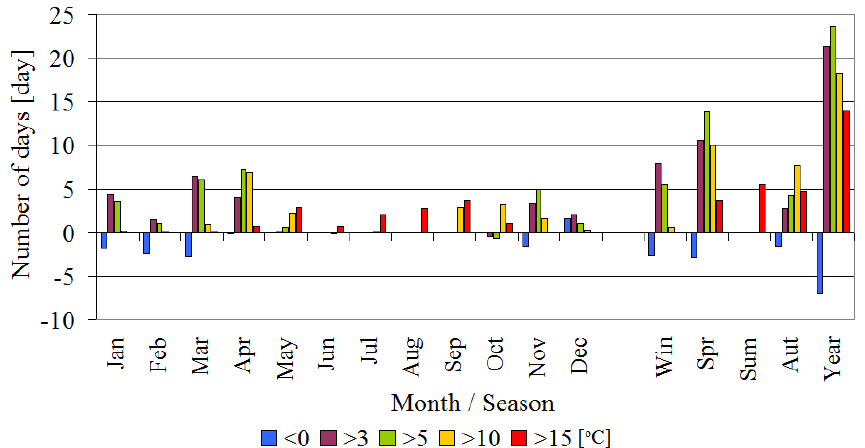
Figure 7. Difference in the number of days with air temperature in different agricultural classes between the decades 2005–2014 and 1951–1960.